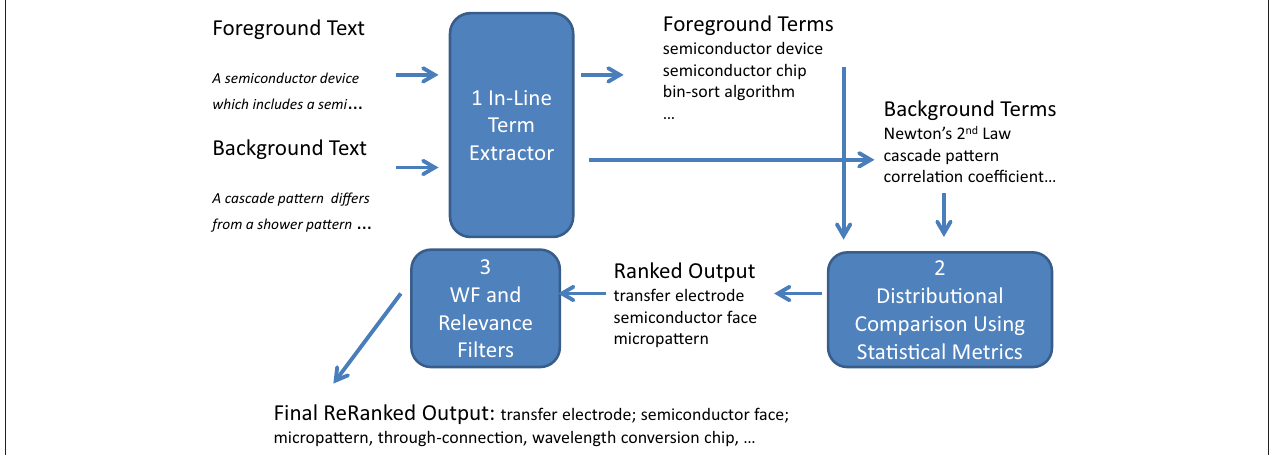
FIGURE 1 | Termolator system